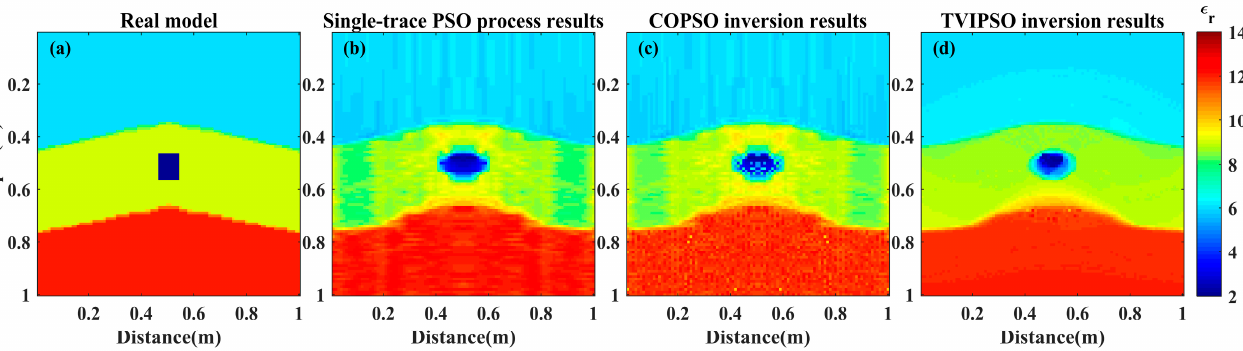
Figure 12. Impacts of the different regularization factors on the fitness error of the TVIPSO algorithm.